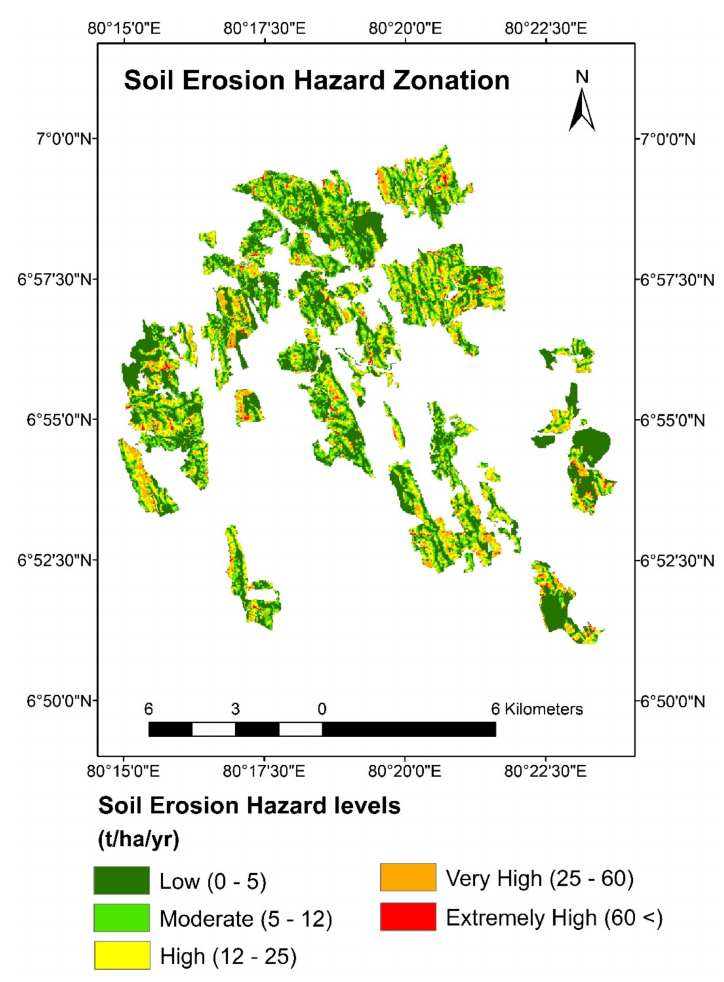
Figure 8. Soil erosion hazard zonation map of the study